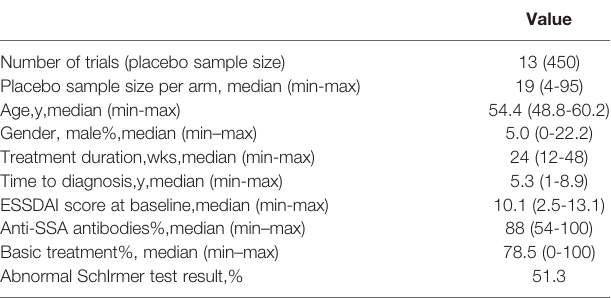
TABLE 1 | Demographic characteristics of included studies.